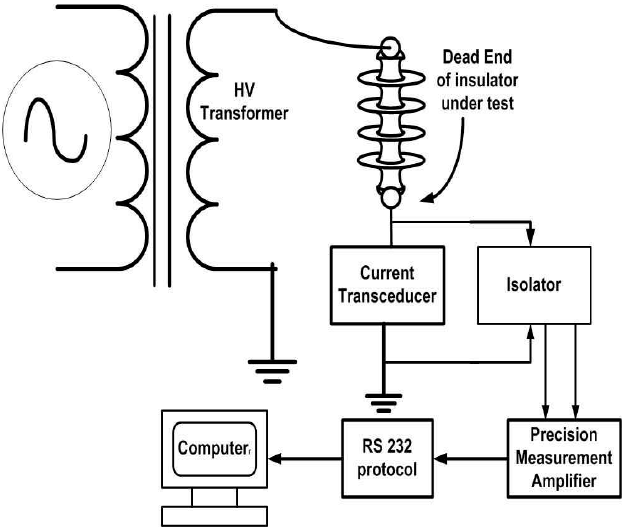
Figure 5. Setup for measurement of leakage current.